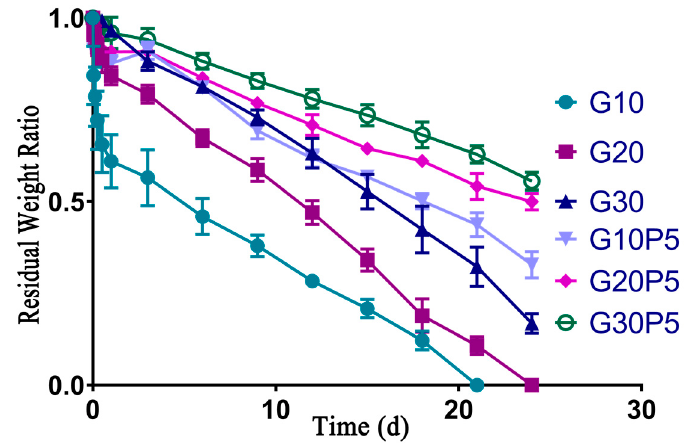
Figure 5. Biodegradation of GelMA and GelMA/PEGDA hydrogel at 37 °C in collagenase type I solution.